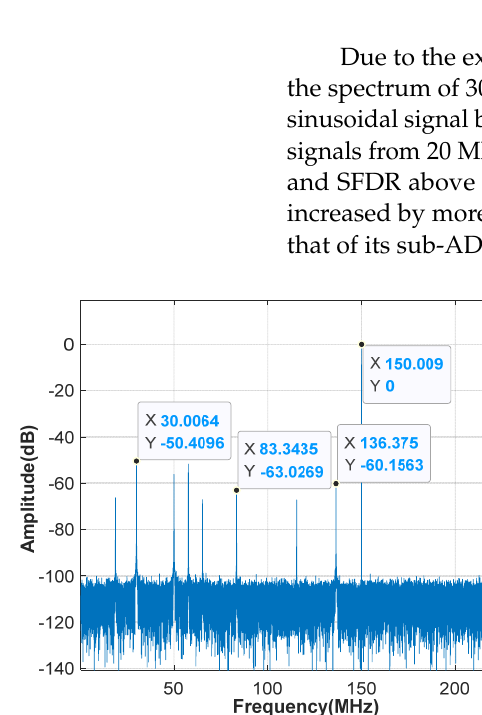
Figure 10. Identification Model Output and Actual Output of Four-Channel TIADC system: ( a ) am- plitude and frequency; ( b ) Phase and frequency.